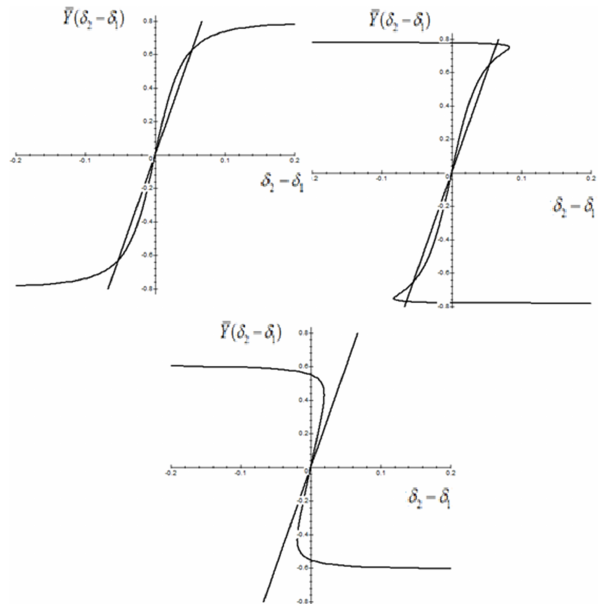
Figure 3. Stationary regimes under a fixed velocity v < v + and variations in the parameter ϕ 1 .